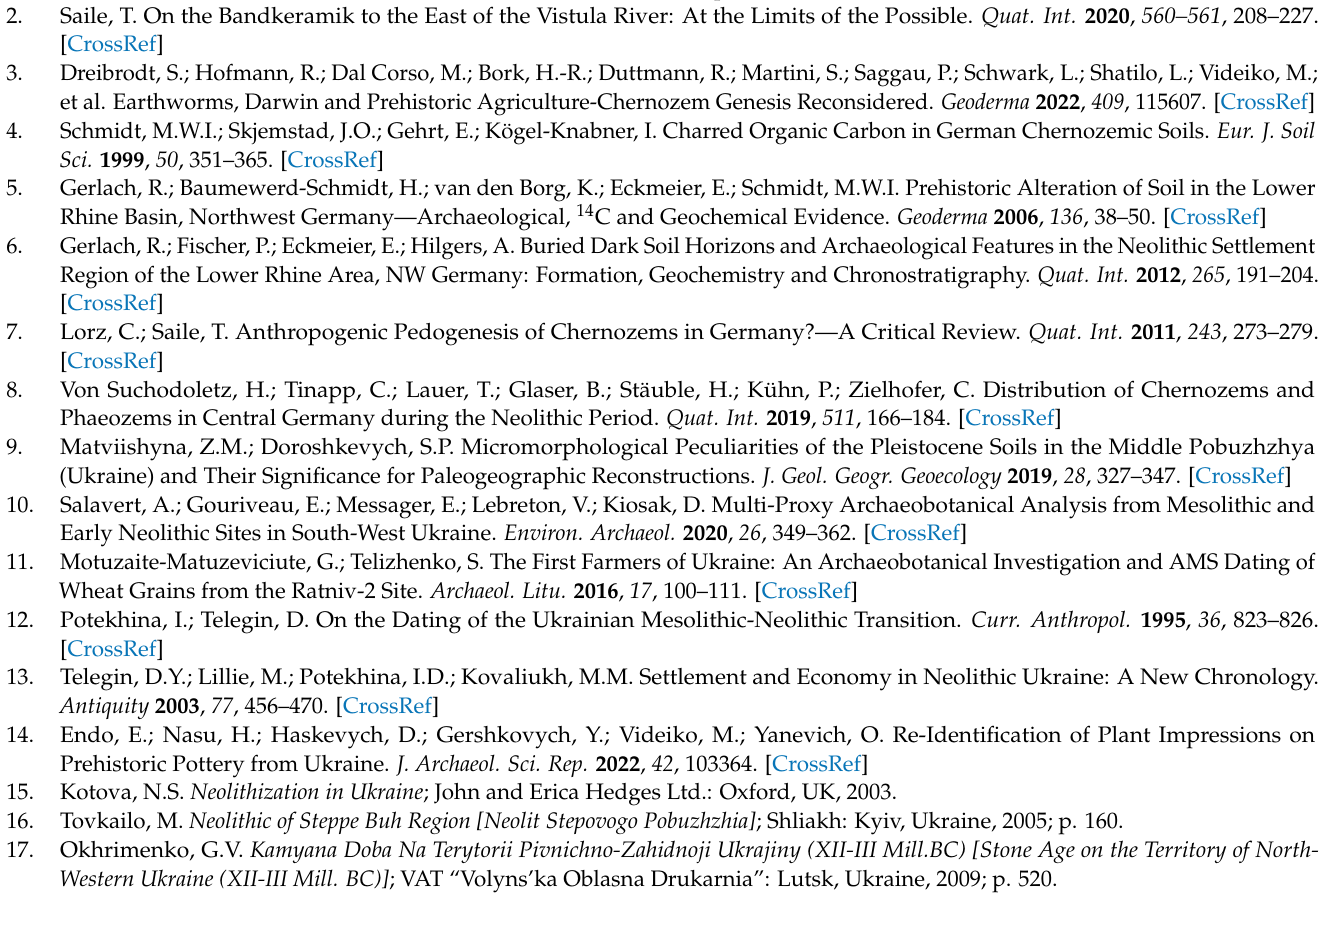
Table S3: Soil section 1 of the Kamyane-Zavallia 1 site, Supplementary Table S4: Soil section 1–2 of the Melnychna Krucha site, Supplementary Table S5: Soil section 1 of the Mykolyna Broiaka